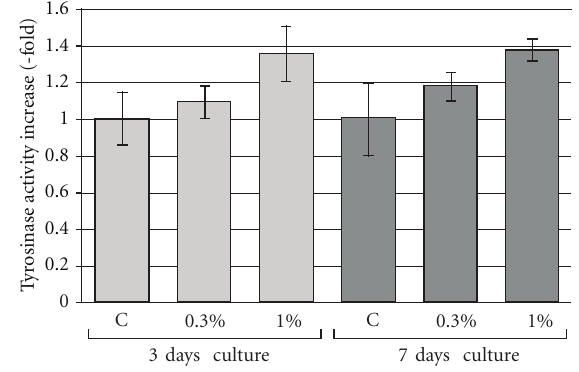
Figure 1: The e ff ect of 0.3% and 1% DMSO on tyrosinase activity in A-375 melanoma cells cultured by 3 or 7 days. Each bar represents the mean ± SD; C: